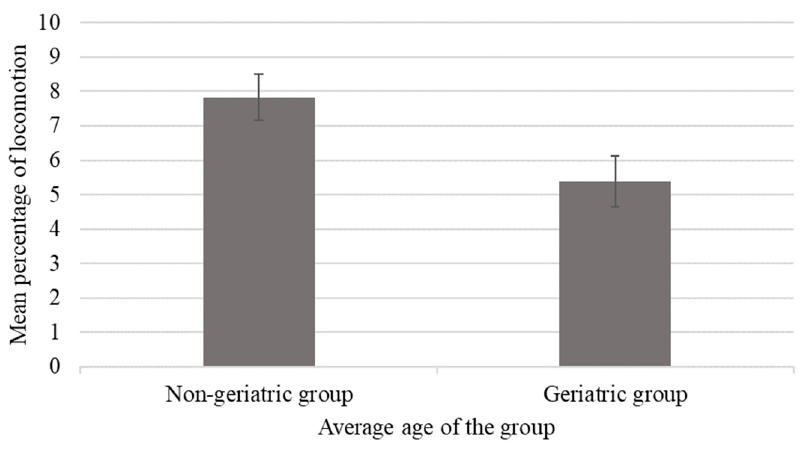
Figure 4. Mean percentage of time spent locomoting as a function of housing in a geriatric (group average age greater than or equal to 35 years) compared to non-geriatric (group average ages less than 35 years) groups. Error bars represent the standard error of the mean. Elderly chimpanzees housed in non-geriatric groups spent more time locomoting than those housed in geriatric groups ( p ≤ 0.05).